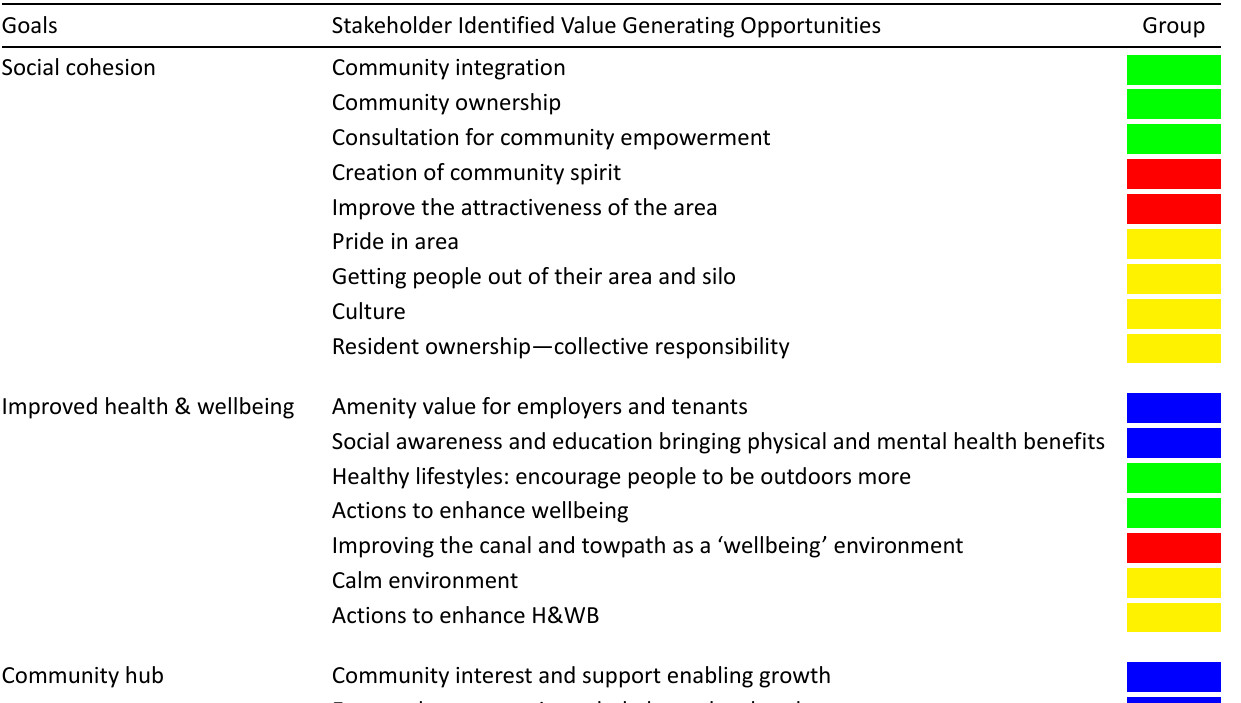
Table 4. High priority value-generating opportunities identified by the four stakeholder groups (denoted by different